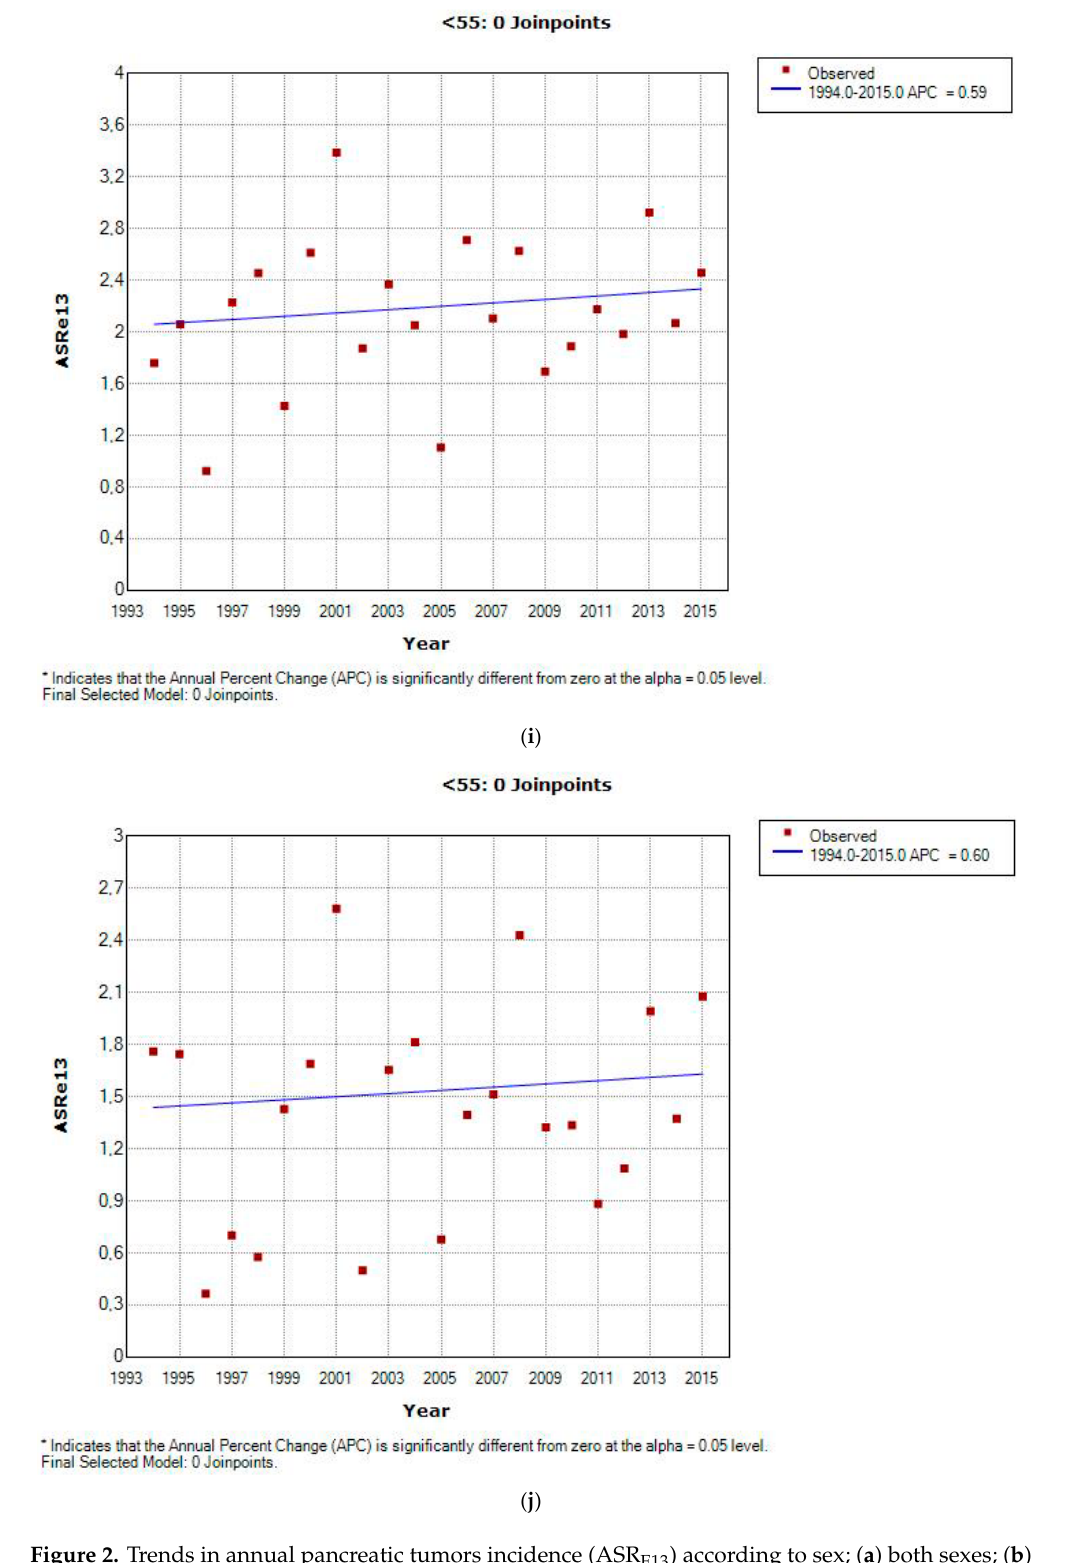
Figure 2. Trends in annual pancreatic tumors incidence (ASR E13 ) according to sex; ( a ) both sexes; ( b ) male; ( c ) female; according to histological groups; ( d ) non PNETS; ( e ) PNETs; ( f ) non histological confirmation. According to age groups; ( g ) All PC ≥ 55 years-old; ( h ) Exocrine tumours ≥ 55 years-old; ( i ) All PC < 55 years-old; ( j ) Exocrine tumours < 55 years-old.